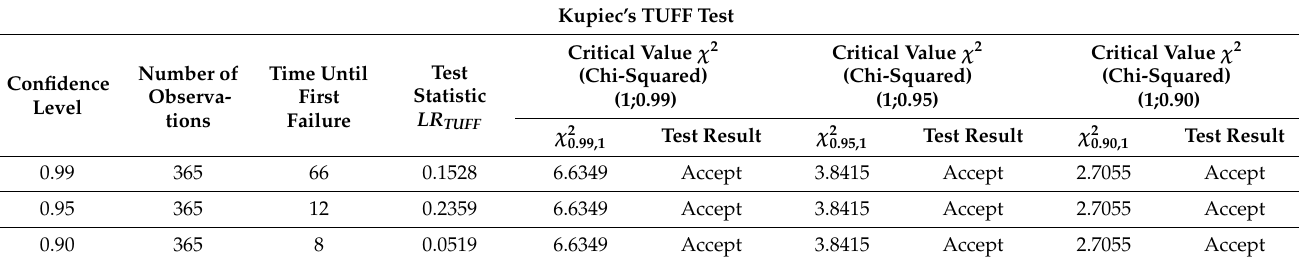
Table 3. Historical simulation VaR Kupiec’s TUFF-test.